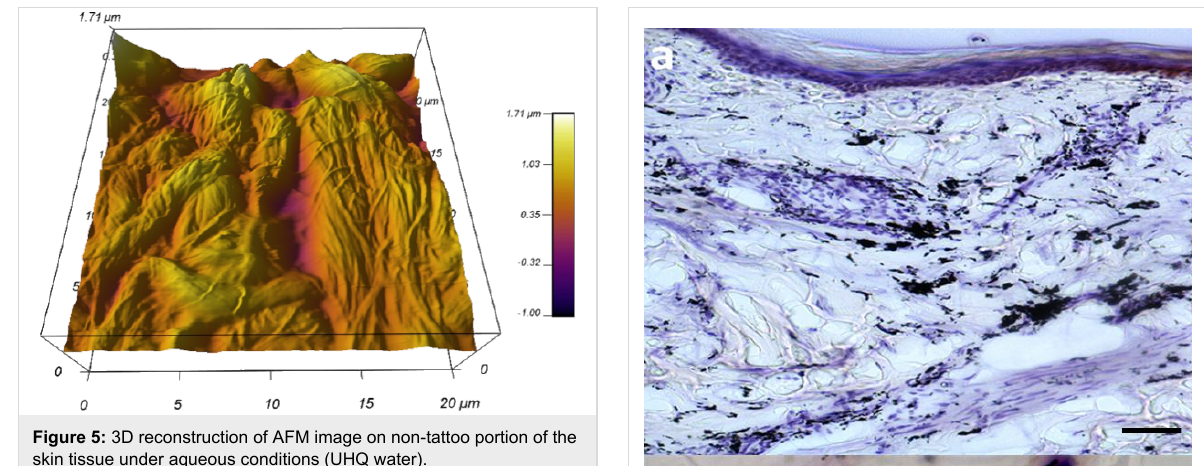
Tattoos inevitably fade over time with a redistribution of the pigments deeper into the dermis and some even entering dermal blood vessels before transportation to local lymph nodes [29].